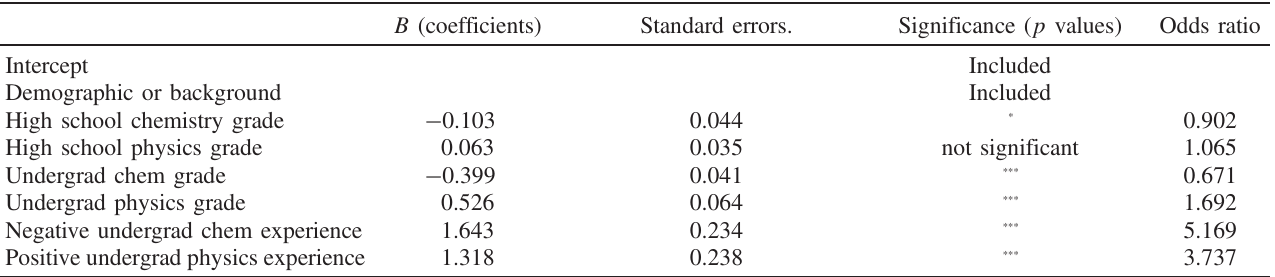
TABLE III. Female physicist logistic regression model summary with odds ratio. B (coefficients) Standard errors.